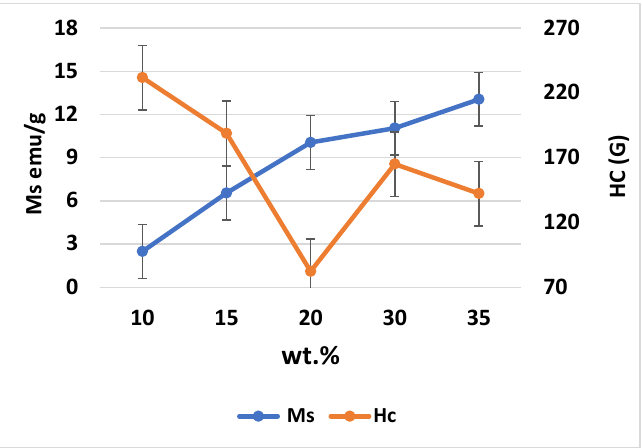
Figure 15. Correlation between Hc and Ms.